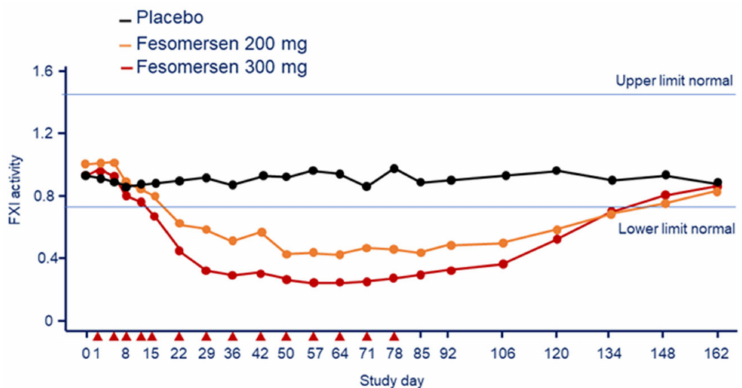
Figure 8. Effect of fesomersen 200 mg and 300 mg on FXI activity compared with placebo during the 78-day treatment period and subsequent 85-day washout period. Red arrowheads indicate dosing day. Modified from Walsh, M. et al. [38]. F: